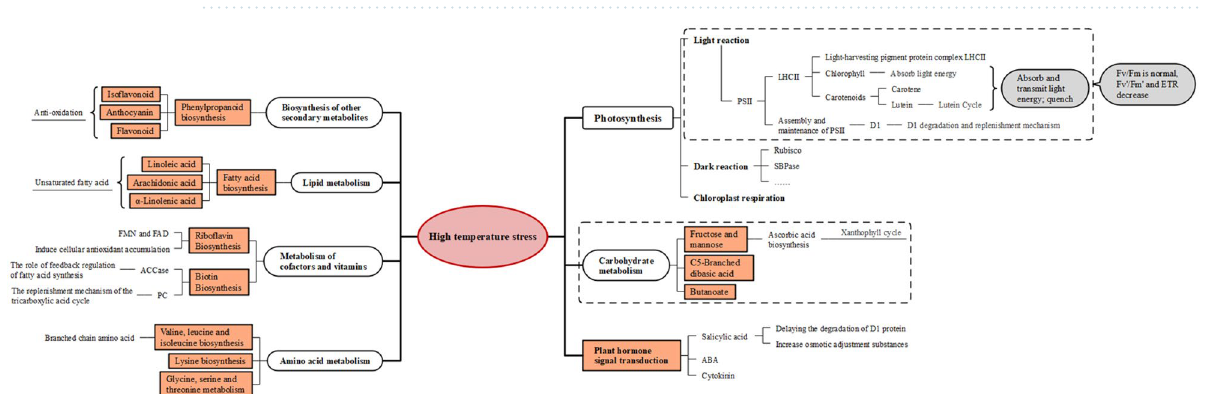
Figure 10. The regulatory mechanism of A. mongolicus under low-temperature stress. The white ovals represent the enriched metabolic pathways. The blue rectangles represent significantly enriched KEGG metabolic pathways. The pathways are followed by the physiological structures and substances or physiological processes in which the expressions of related genes change.